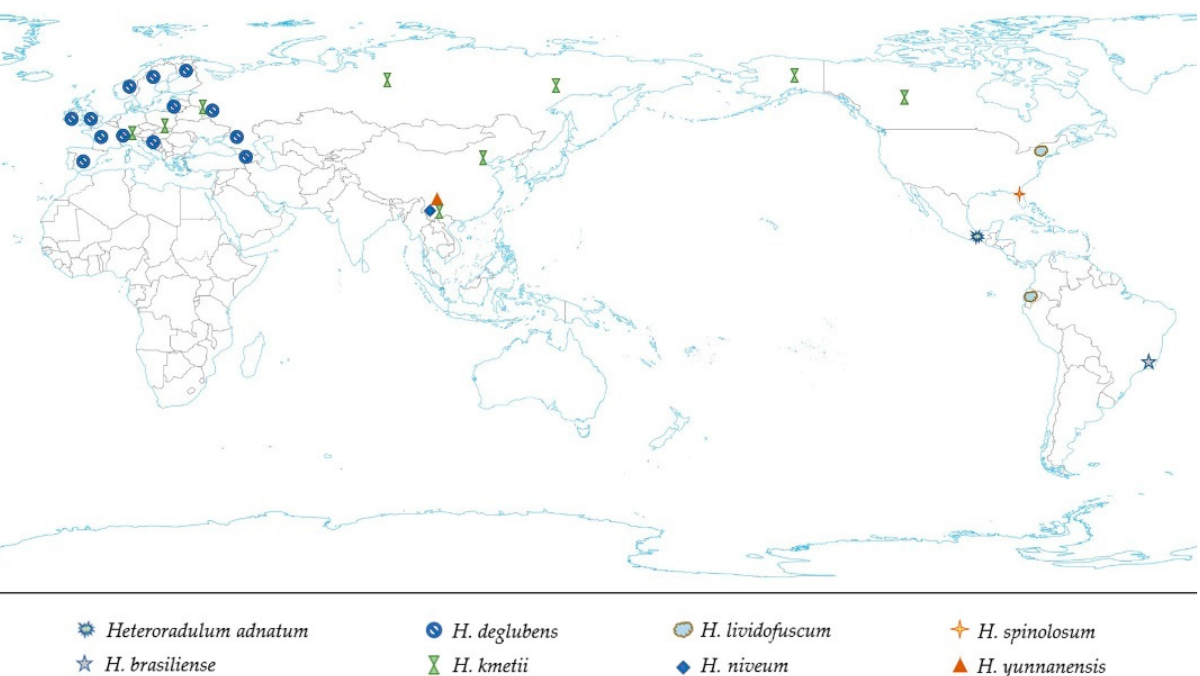
Figure 5. Geographic distribution of Heteroradulum species worldwide.